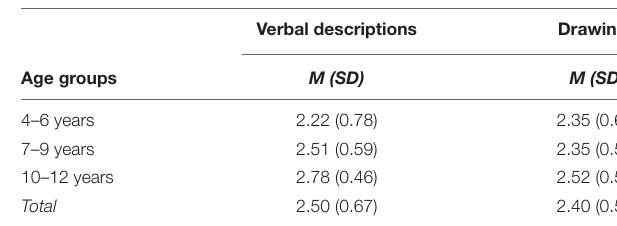
TABLE 1 | Mean scores (and standard deviations) of children’s verbal descriptions and drawings of coronavirus by age